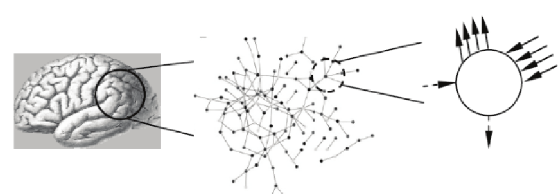
Fig. 1. Schematic representation of computational